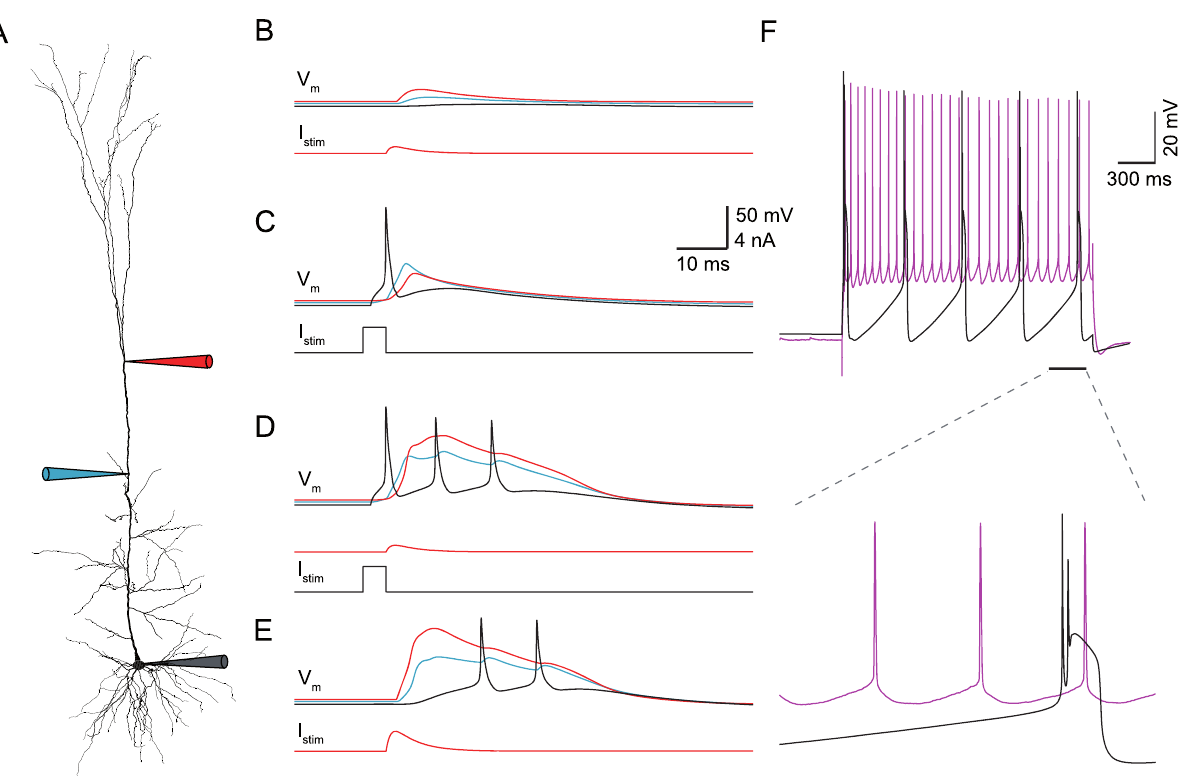
Figure 1. Models constrained only by BAC firing may fail to respond properly to perisomatic step current. A. Reconstructed morphology of an L5b neocortical pyramidal cell, age p36, used for the fitting and simulations. Recording and stimulation sites are indicated by schematic electrodes at the soma (black), proximal apical dendrite (400 m m from the soma, blue) and distal apical site (620 m m from the soma, red). (B–E). Model simulation of BAC firing (compare to [6]). B . EPSP-like current injection at the distal dendrites (I stim , red trace) with peak amplitude of 0.5 nA produced a subthreshold depolarization of 2.5 mV at the soma (V m , black trace). C. Suprathreshold step current at the soma evoked a somatic AP that back-propagated into the dendrites. D. BAC firing. The combination of somatic and dendritic current injection (separated by an interval of 5 ms) evoked a dendritic Ca 2 + spike (V m , red trace) followed by a burst of two additional somatic APs. E. Dendritic Ca 2 + spike could be evoked by an intense (2.5 nA) current injection to the distal dendrite alone, also evoking two APs at the soma. F. Top: the model’s firing response to somatic step current injection did not agree with the experimentally observed response (black–model, magenta–experiment). Bottom: 300 ms of the response corresponding to the bar in the top part.